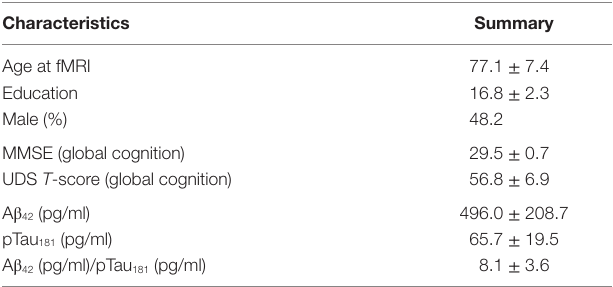
TaBle 1 | characteristics of UK-aDc biomarker study participants ( n =